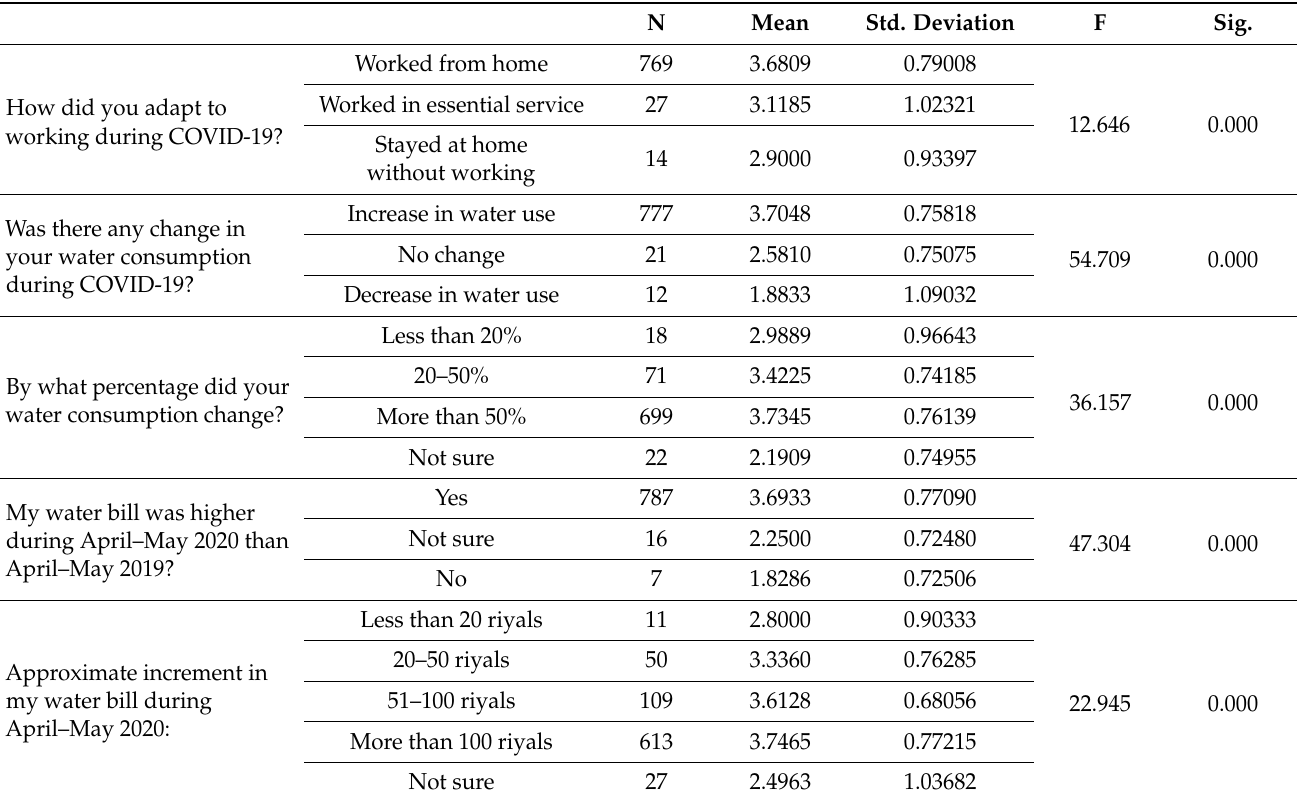
Table 4. ANOVA test for differences in water-use behavior based on household water consumption. N Mean Std. Deviation F